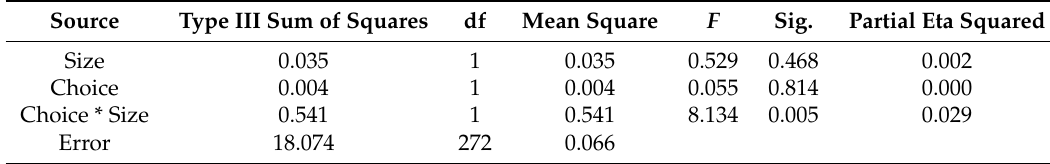
Table 6. Tests of between-subject effects of size and